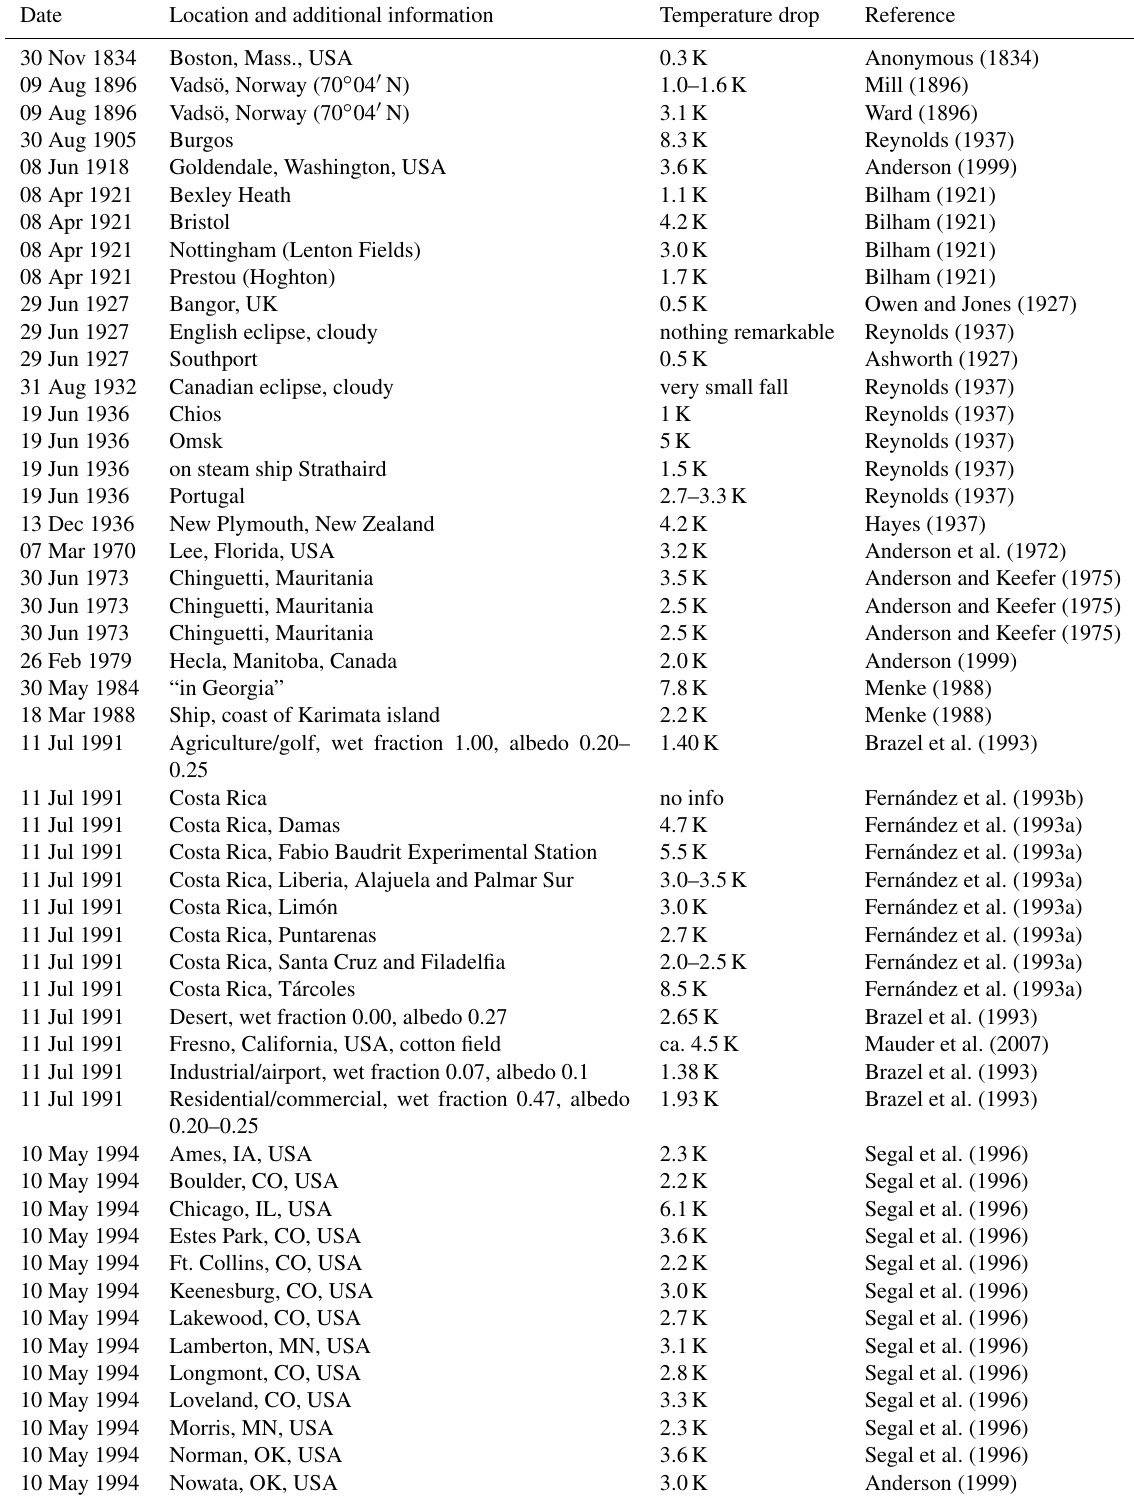
Table 1. Compilation of literature reports on temperature drops during maximum occultation of an eclipse since 1834. Most reports are from total or annular eclipses but a few studies also report values from partial eclipses or partial occultation at a given locality. More observations are tabulated in Aplin et al. (2016) but not all these reports allow the calculation of the temperature